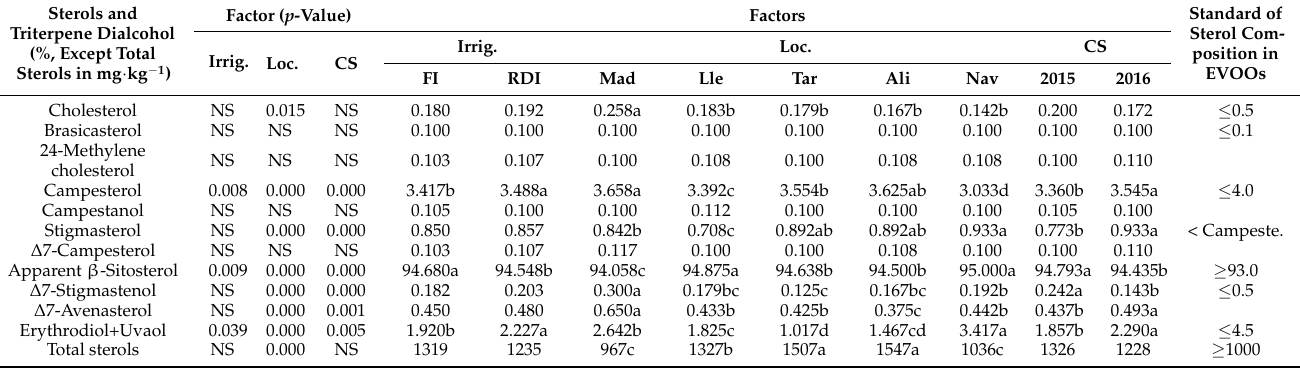
Table 4. Three-way ANOVA (prob > F) and least square means of sterols and triterpenes dialcohols compositions for the different factors: Irrig: irrigation (full irrigation: FI; regulated deficit irrigation: RDI); Loc: locality (Mad: Madrid; Lle: Lleida; Tar: Tarragona; Ali: Alicante; and Nav: Navarra); and CS: crop season (2015 and